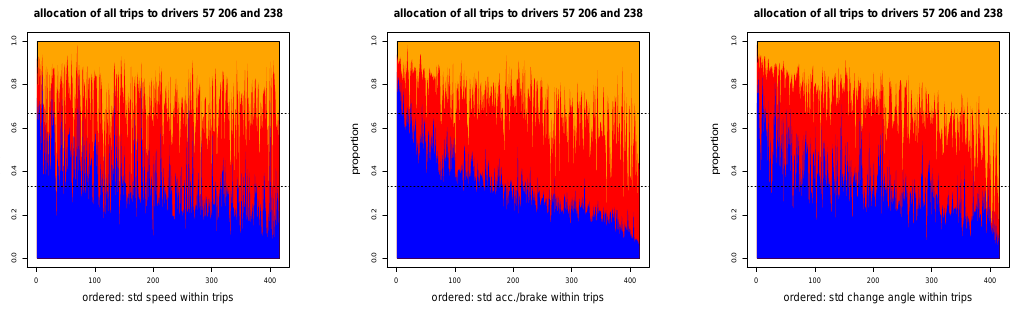
Figure 13. Relative allocation of the individual trips of drivers i = 1, . . . ,416 to drivers 57 (blue), 206 (red) and 238 (orange): individual drivers are ordered w.r.t. σ v ( left ), σ a ( middle ) and σ ∆ ( right